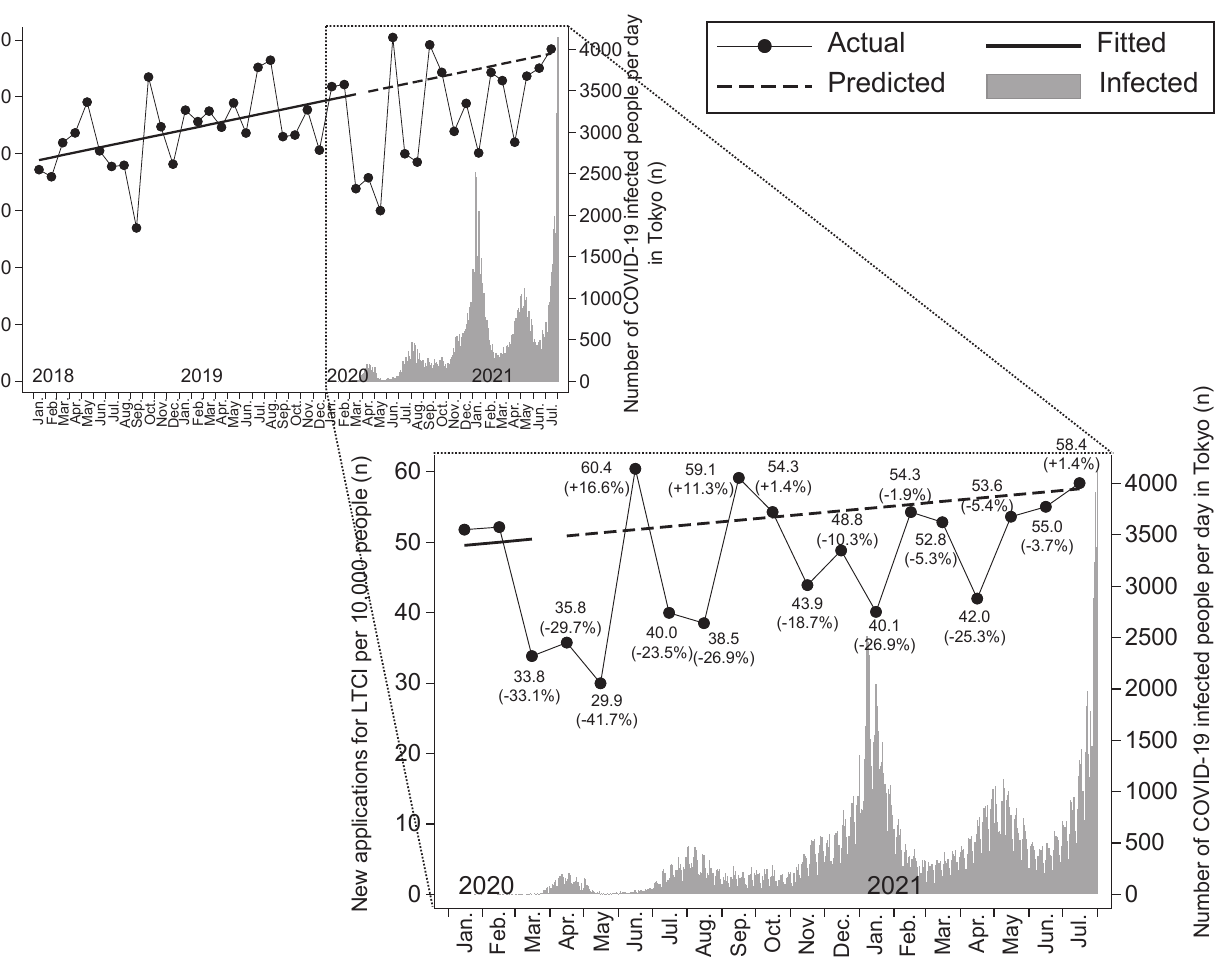
Figure 1. Number of new LTCI applications per 10,000 people monthly in Ota City cohort and the number of COVID-19 infected people per day in Tokyo. The solid line represents the regression line applied to the number of new LTCI applications from January 2018 to February 2020. The dotted line shows the predicted values based on regression. The grey bar shows the number of people infected with COVID-19 per day in Tokyo. The value in parentheses represents the percentage of the di ff erence from the predicted value. COVID-19, novel coronavirus disease 2019; LTCI, long-term care